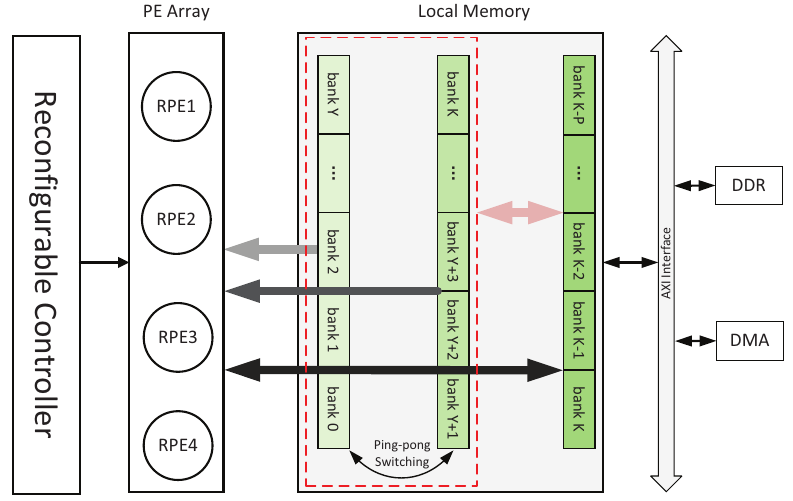
Figure 4. Ping-pong operation for computing the covariance matrix. PE, processing